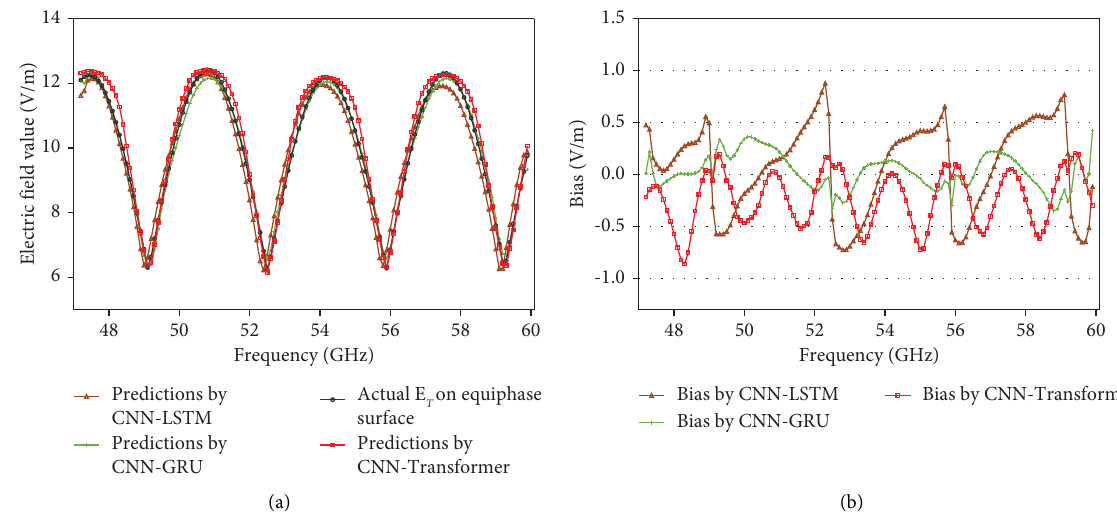
Figure 11: (a) Prediction results of a vertical dipole measured in a FAC: length h � 2U and 6U, distance d � 10m. (b) Deviation in the predicted results and the actual electric feld on the equiphase